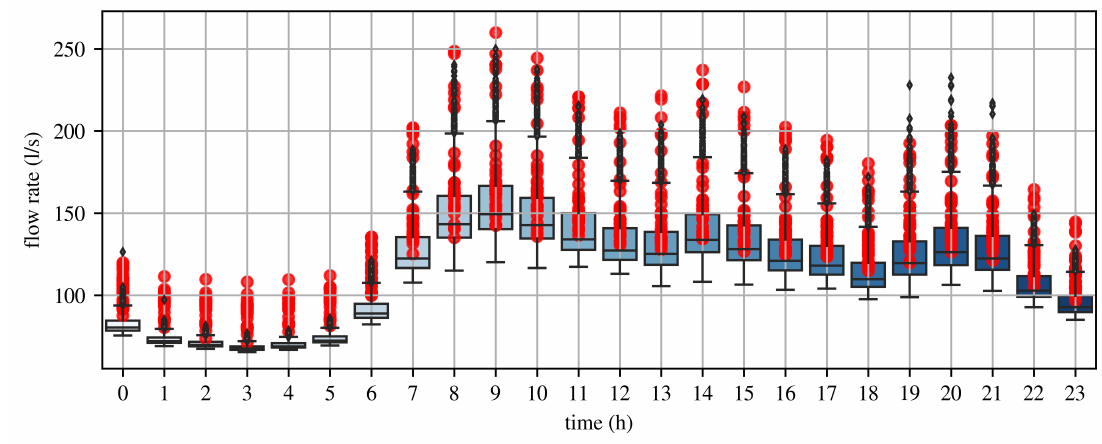
Figure 6. Box & Whiskers plot of the four-year Apulian consumption for each hour of the day. The red points represent hours where at least a burst is active, and black boxes and points stand for normal